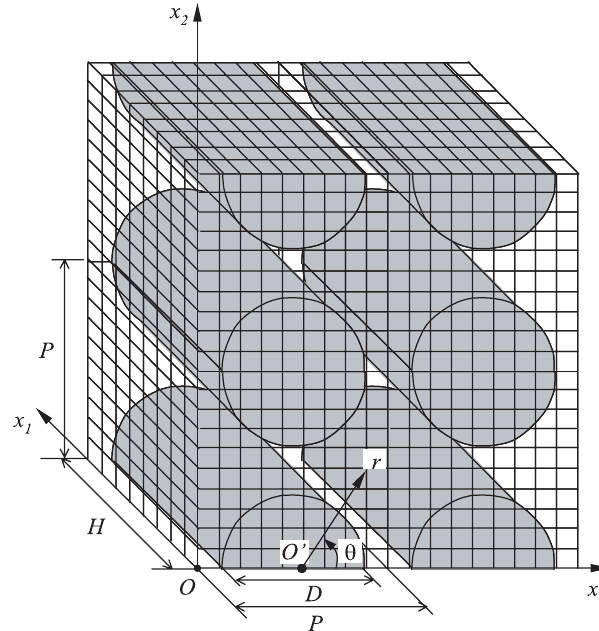
Fig. 3 Computational domain for